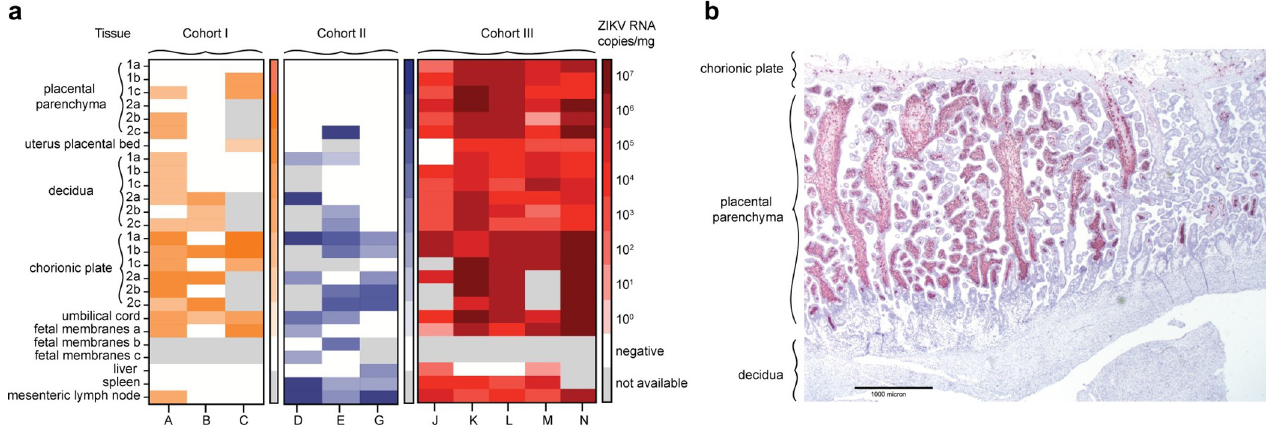
Fig 4. ZIKV was detected in tissues from the maternal-fetal interface (MFI) and dam in all cases of early pregnancy loss. Cohort I (SIV+/ZIKV+ +ART) animals are in orange, Cohort II (SIV-/ZIKV+ +ART) animals are in blue, and Cohort III (SIV-/ZIKV+) animals are in red. (a) ZIKV was detected in MFI and maternal tissues from Cohorts I-III by ZIKV-specific RT-qPCR. The placenta was segmented into cotyledons, labeled as ’a’, ’b’, and ’c’, and a sample was obtained from each layer (decidua, parenchyma, chorionic plate) within every cotyledon. Maternal tissues were taken by biopsy at the time of C-section. (b) Representative image of ZIKV RNA (red staining) detected by in-situ hybridization (ISH) in the first placental disc from a case of pregnancy loss (Pregnancy K). Here, there was marked diffuse villous parenchymal staining extending from the basal plate to the chorionic trophoblastic shell with transmural segmental sparing of